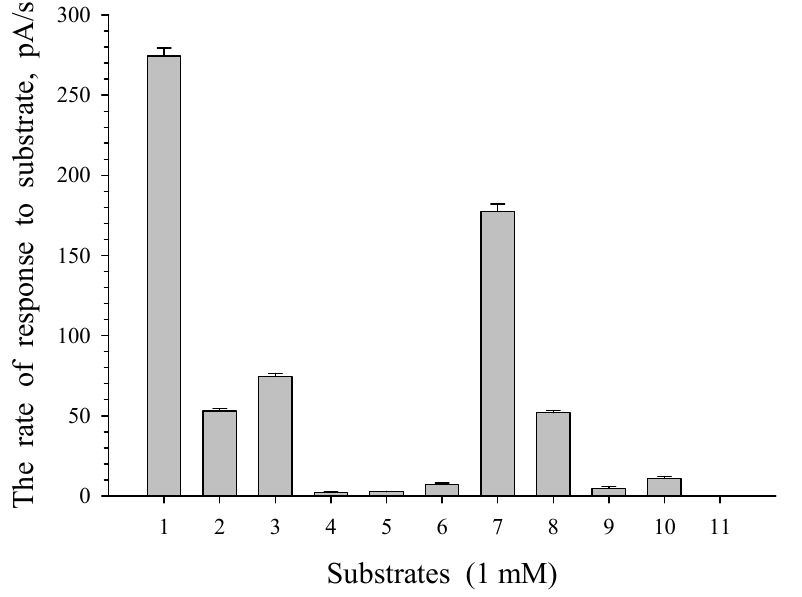
Figure 13. Substrate specificity of immobilized cells of G. polyisoprenivorance 135. 1—Benzoate, 2—sucrose, 3—glucose, 4—arabinose, 5—xylose, 6—maltose, 7—acetate, 8—pyruvate, 9—citrate, 10—succinate, and 11—salicylate.